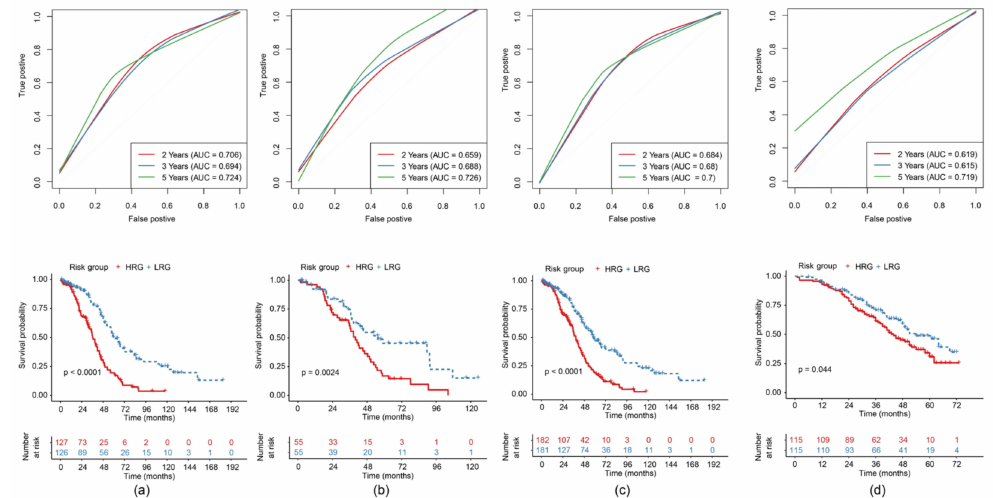
Figure 4. Construction and evaluation of the 11-gene risk model with each receiver operating characteristic (ROC) curve (area under the curve (AUC) of the 2-year, 3-year and 5-year predictive effect) above and the KM (Kaplan-Meier) curve comparing high-risk group (HRG) and low-risk group (LRG) beneath for: ( a ) TCGA training cohort; ( b ) TCGA testing cohort; ( c ) TCGA-(epithelial ovarian cancer (EOC) cohort; ( d ) GEO Series 32026 (GSE32026)